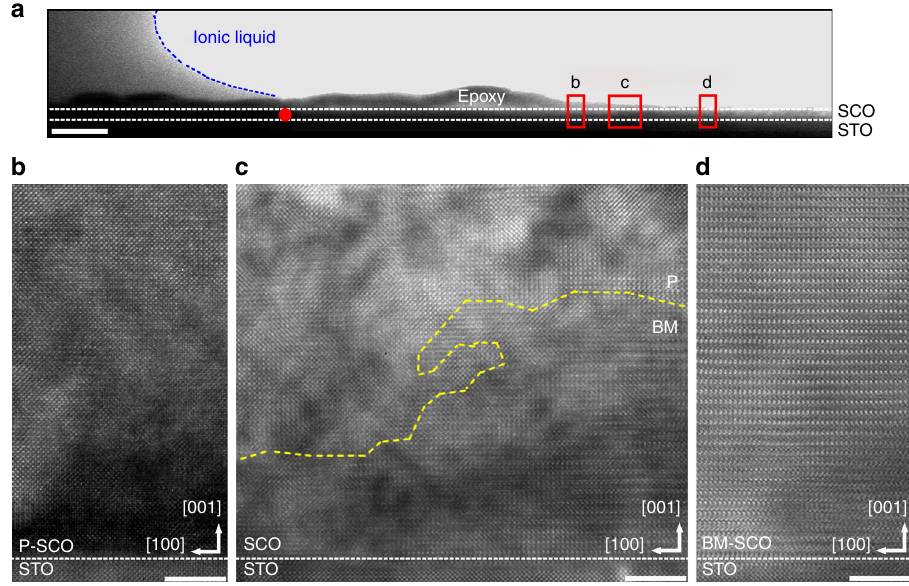
Fig. 3 Distance-dependent ionic liquid gating effect. a Overview of in situ TEM sample, where the selected areas for high magni fi cation images are marked by red boxes. The while scale bar in a corresponds to 200 nm. The edge of the ionic liquid (IL) is indicated by a blue dashed line. The distances between the ionic liquid and selected areas are estimated with respect to the red point and the centers of the red frames. The TEM images of selected areas at different distances from the edge of the IL, after gating at V G = – 3 V for 12 min: b d ≈ 1.03 μ m; c d ≈ 1.19 μ m; and d d ≈ 1.51 μ m. The interface between the SCO fi lm and the STO substrate is shown as a white dashed line. The yellow dashed line in c shows the boundary between brownmillerite (BM) and perovskite (P) SCO phases. The white scale bars in b – d are 5